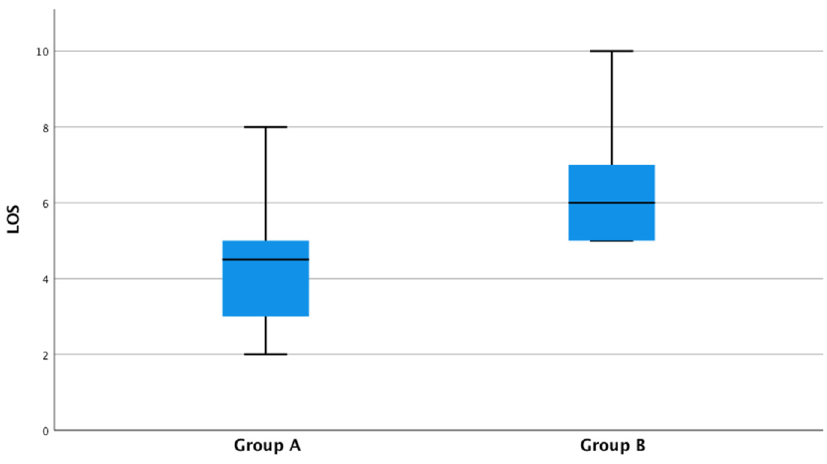
Figure 4. In group A with ERAS (mean 4.51, range 2–8, SD 1.4) compared with the group B without the ERAS (mean 6.23, range 5–10, SD